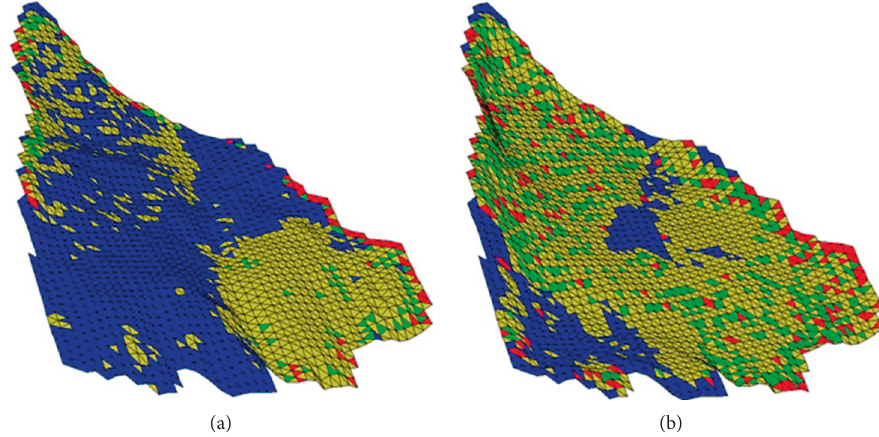
Figure 19: The plastic zones of the landslide deposit (a) and the slip zone (b) in rainfall condition.